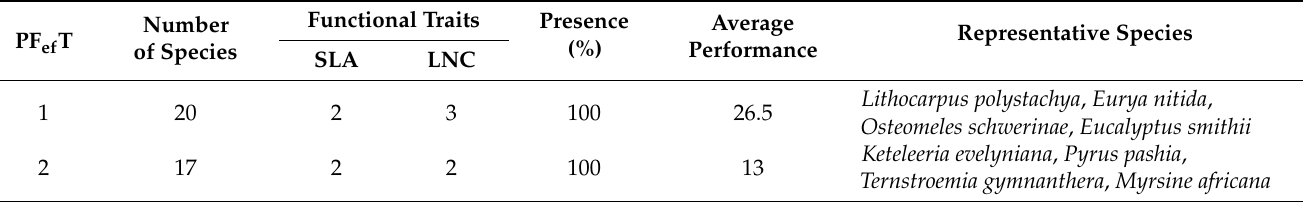
Table 3. Plant functional traits and the identification of two plant functional response types (PF re